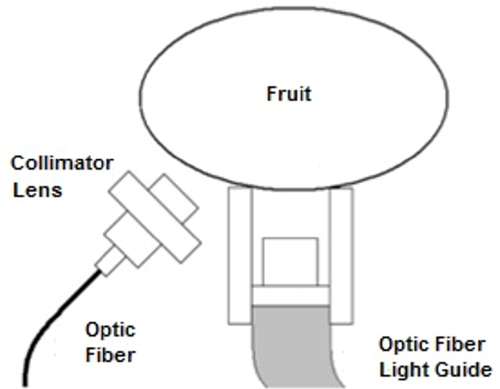
Figure 1. Optics